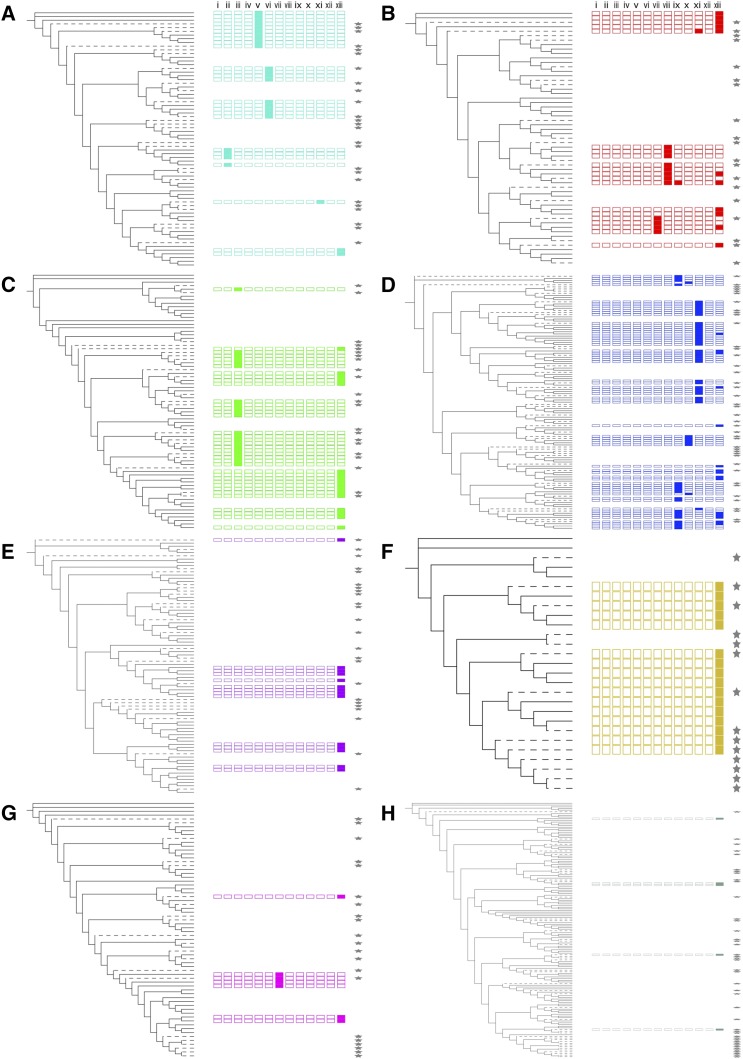
Conserved domains in the CTD of NAC transcription factors arranged by phylogenetic position. Known CTD motifs are shown alongside the wheat, barley, and rice NAC TFs for each group a–h (A–H), colored in accordance with Figure 2. Branches corresponding to wheat NAC TFs are solid black; those for rice and barley NAC TFs are dashed. Motifs are shown as boxes, matching (left to right) motifs i–xiii from Ooka et al. (2003). Motifs that are present in each protein (P-value < 0.05, q-value < 0.05) are shown by a solid-colored box, while absent motifs are shown by an empty outlined box. Genes with no significant motifs are shown with empty space. Barley and rice genes are indicated by the presence of a star to the right of the CTD motifs. Details are presented in Table S5, and the full phylogenetic tree is presented in Figure S2. CTD, C-terminal domain; TF, transcription factor.